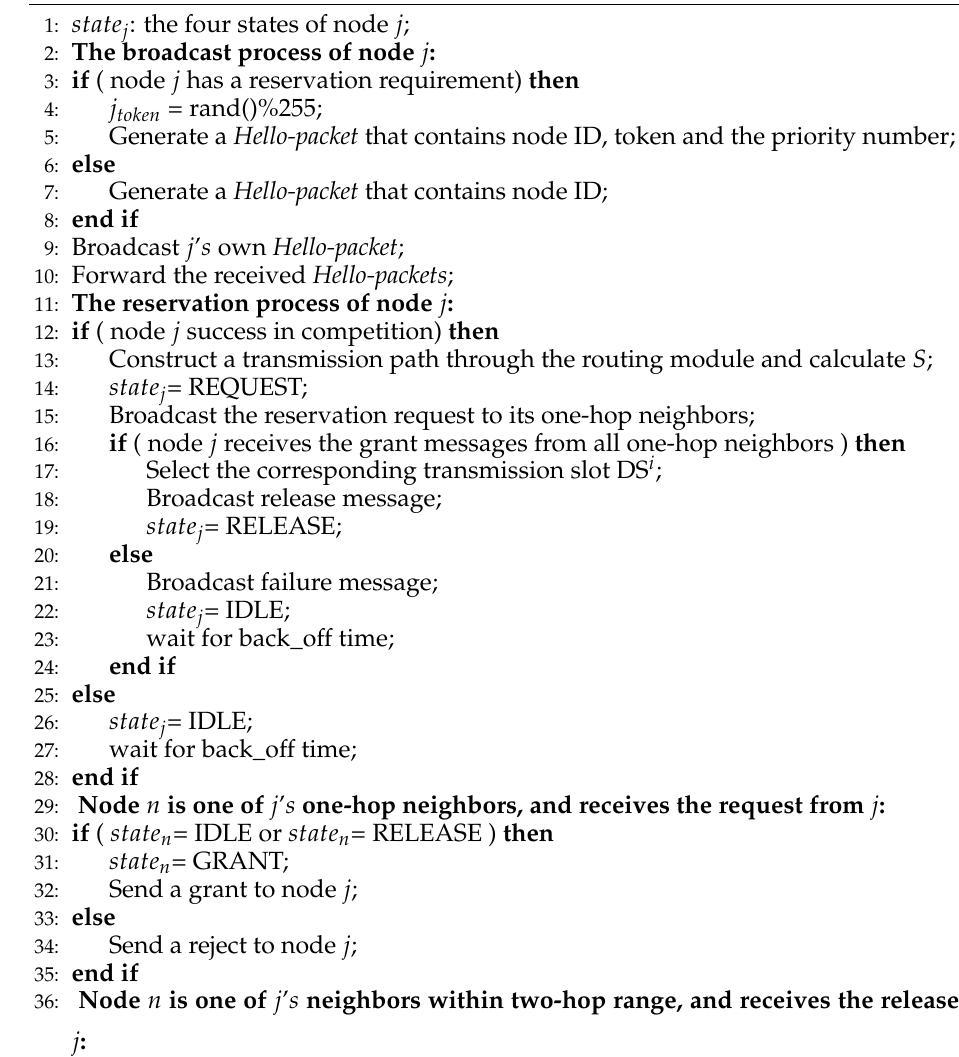
Algorithm 1 The SP-DS Time Slot Allocation Algorithm of Node